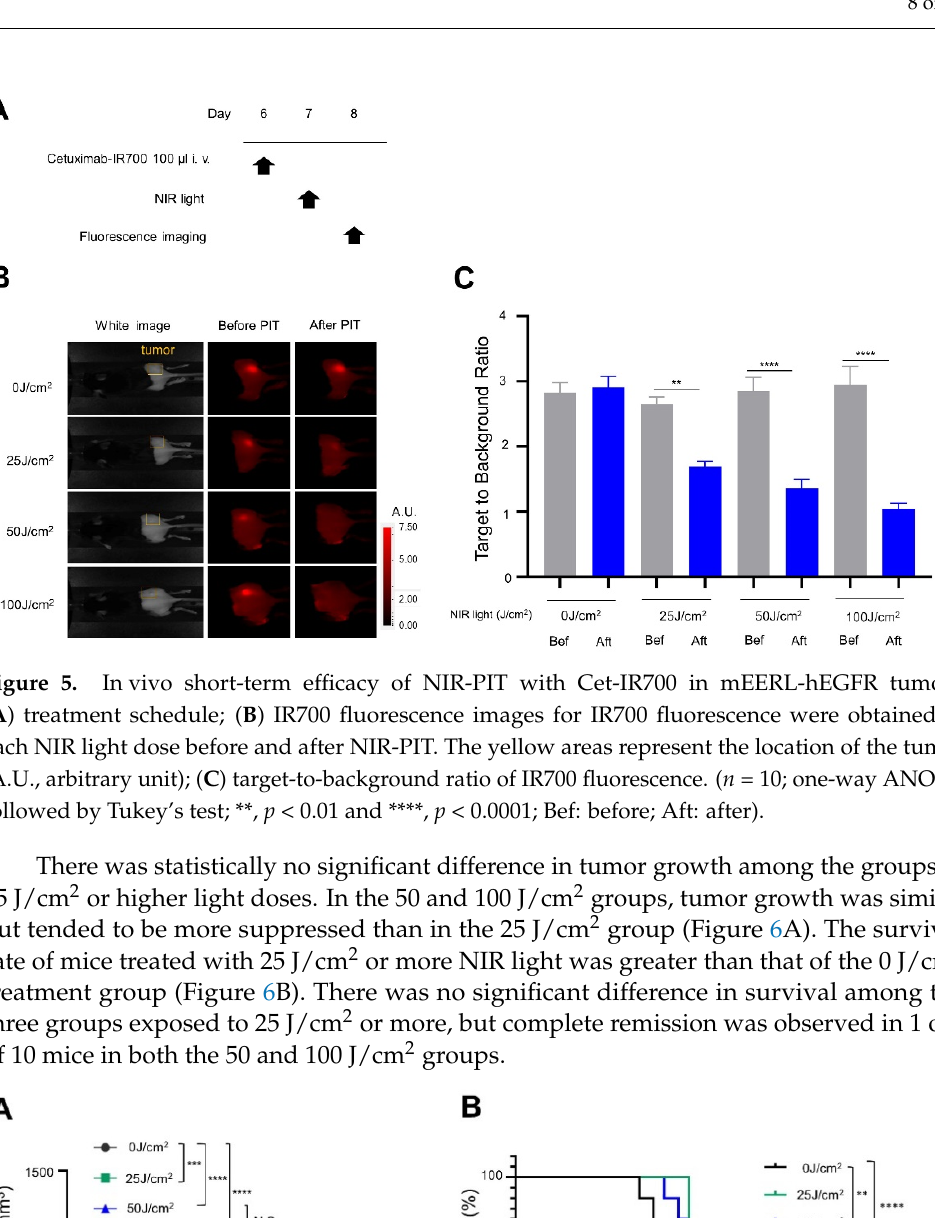
Figure 7. Side effect of NIR-PIT with Cet-IR700 in mEERL-hEGFR tumors: ( A ) edema was assessed by T2WI fat-sat MRI in the NIR-PIT-treated mice at 24 h; ( B ) the range of high signals was quantified using Image J ( n = 3; one-way ANOVA followed by Tukey’s test; *, p < 0.05 and **, p < 0.01); ( C ) the appearance 24 h after light exposure, where the yellow circles indicate the edema-affected area; ( D )